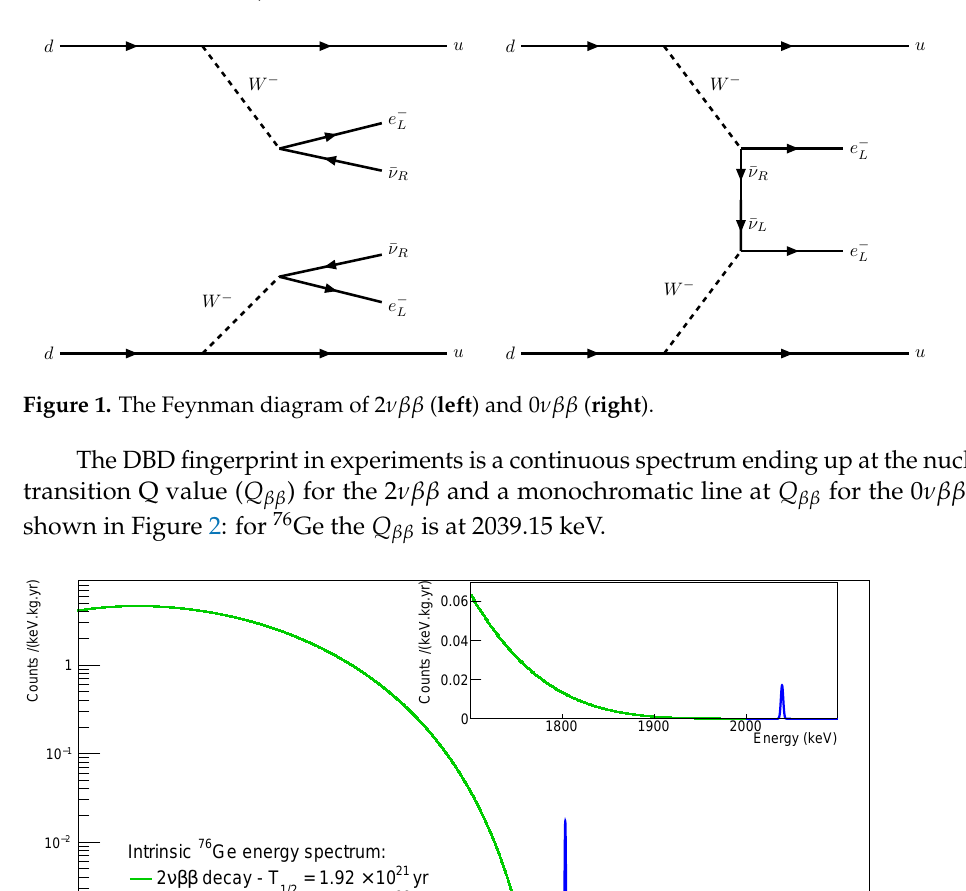
10 21 yr and 1.0 ·